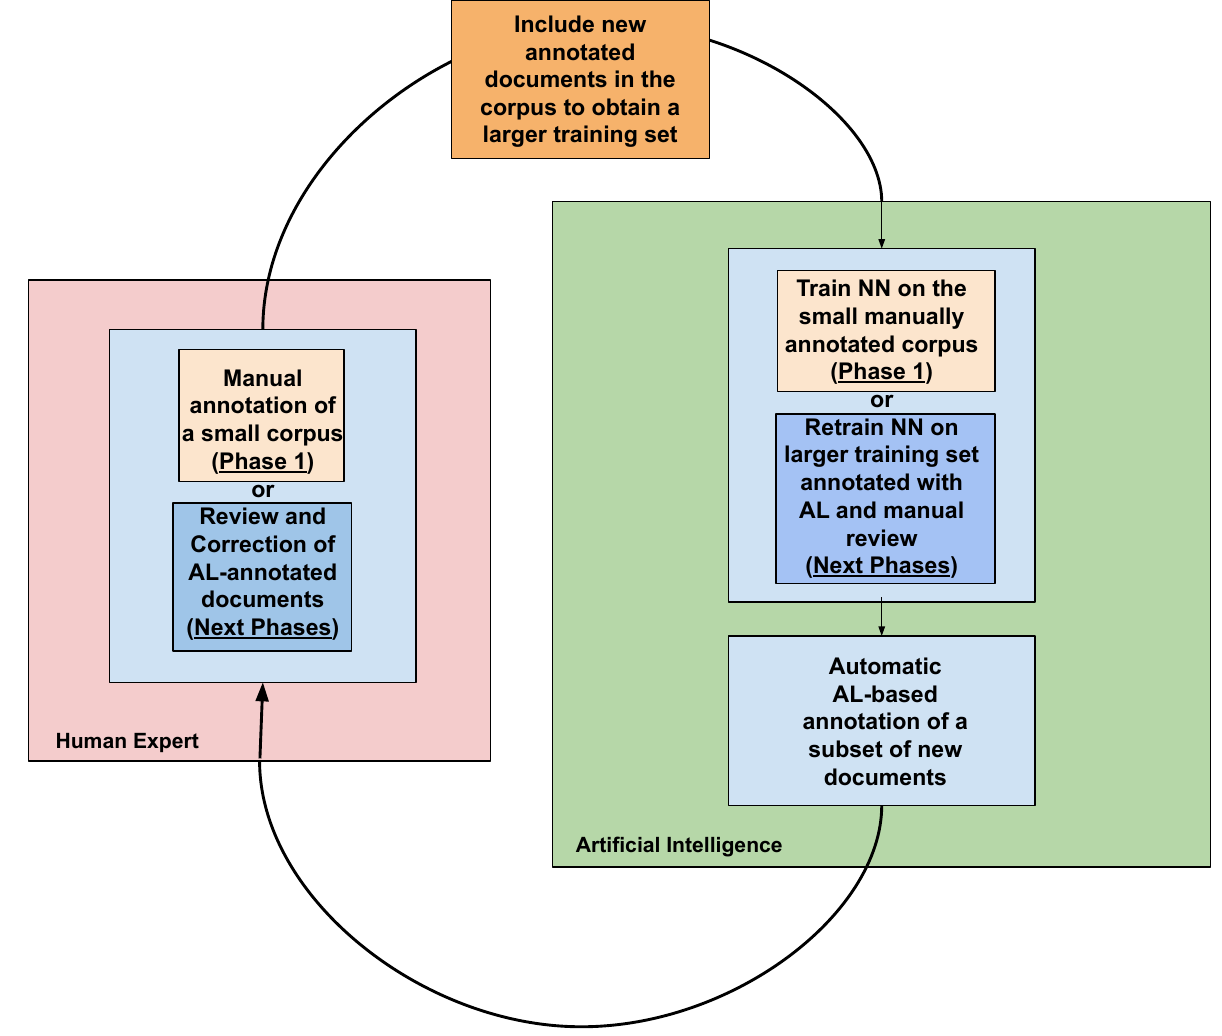
Figure 1. Schematic representation of the active learning annotation